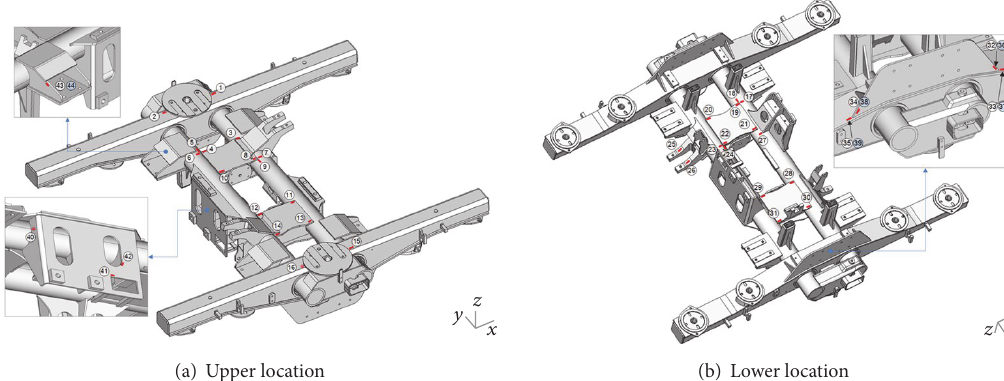
Figure 3: Strain gauge location for static